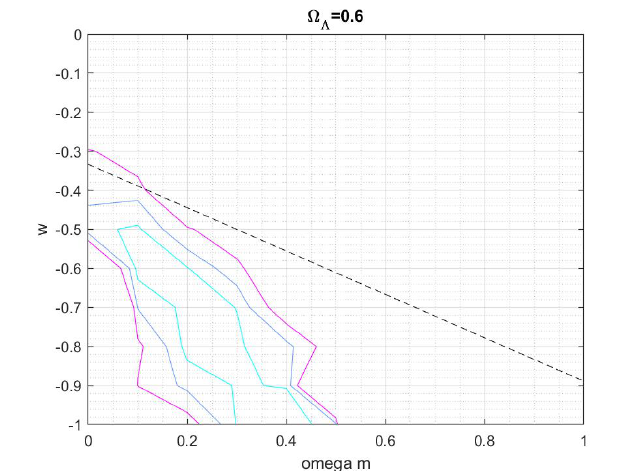
Figure 4: Plot of w against Ω m for Ω Λ = 0 . 6, with 1 σ , 2 σ and 3 σ contour lines corresponding to a di ff erence in χ 2 values for 3 parameters, since we run through 3 parameters instead of just 2. The best fit value is Ω m = 0 . 4, w = − 1 and Ω Λ = 0 . 6 with a χ 2 of − 229 . 8145.